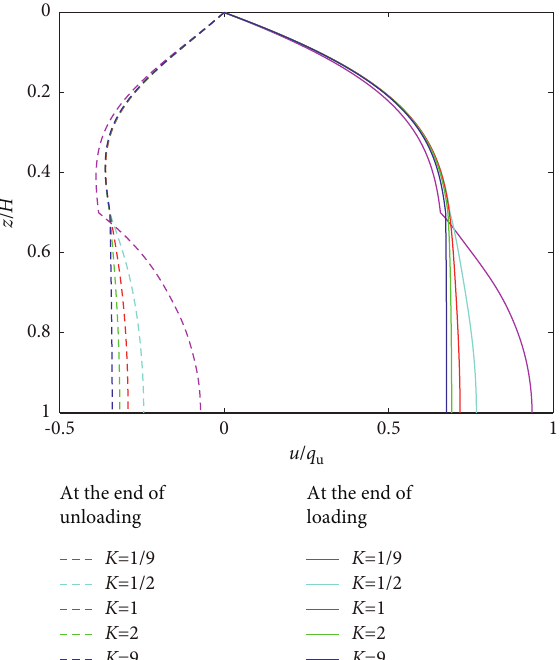
Figure 6: The excess pore pressure isochrones under different values of K